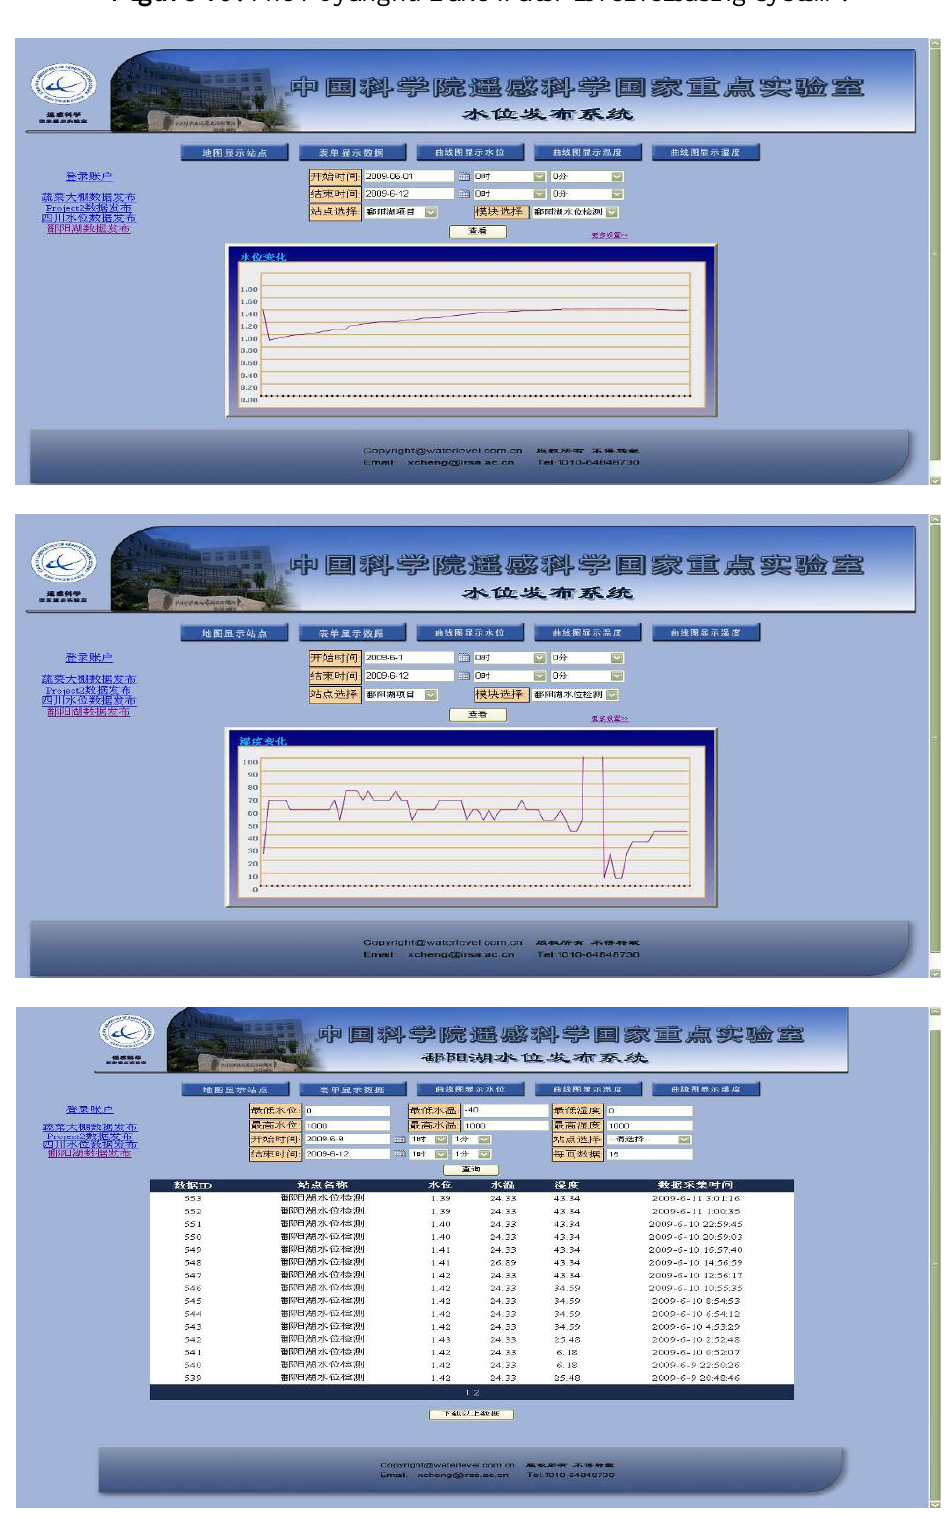
Figure 10. The Poyanghu Lake water-level releasing